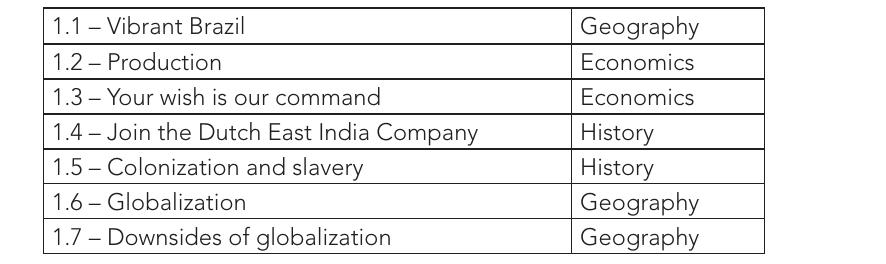
Table 4: Overview of theme 1 year 2 within the ‘human and society’ curriculum of School